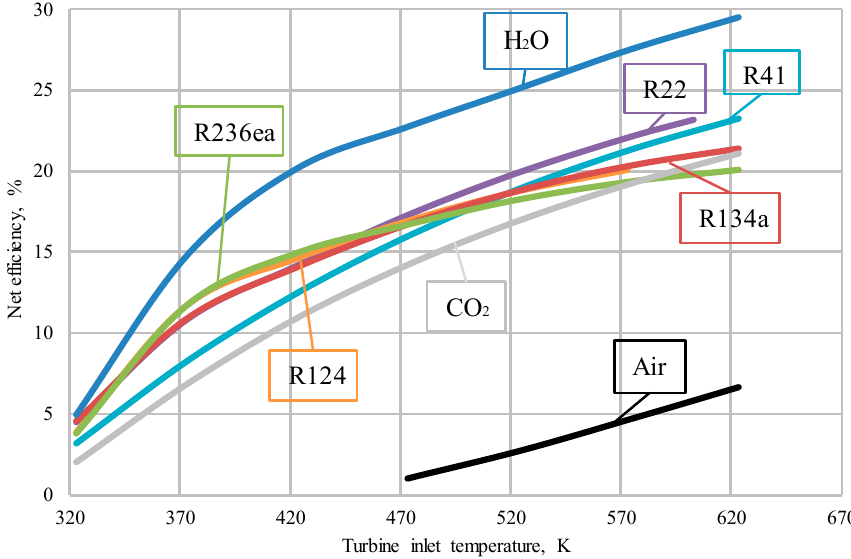
Figure 12. Maximum efficiencies for simple cycles at different initial temperatures.